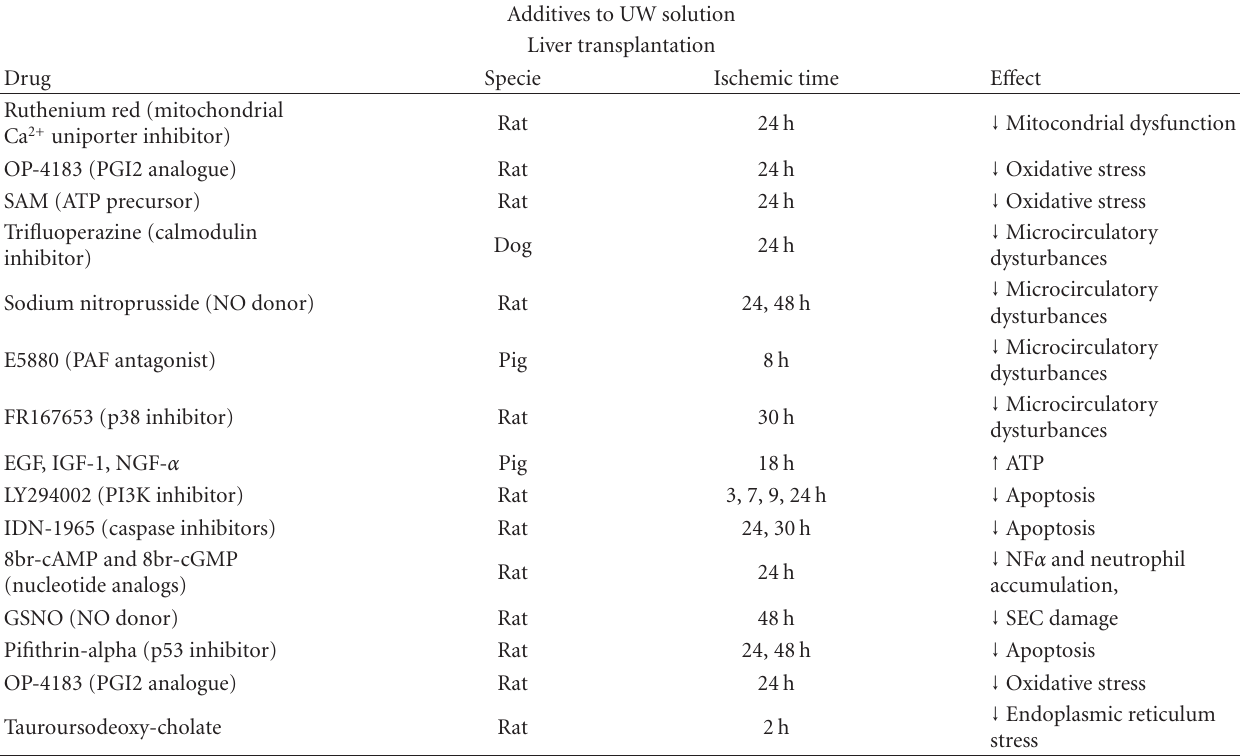
Table 2: Additives to UW solution to protect liver against ischemia/reperfusion. Nitric oxide, NO; platelet-activating factor, PAF; sinusoidal endothelial cells,